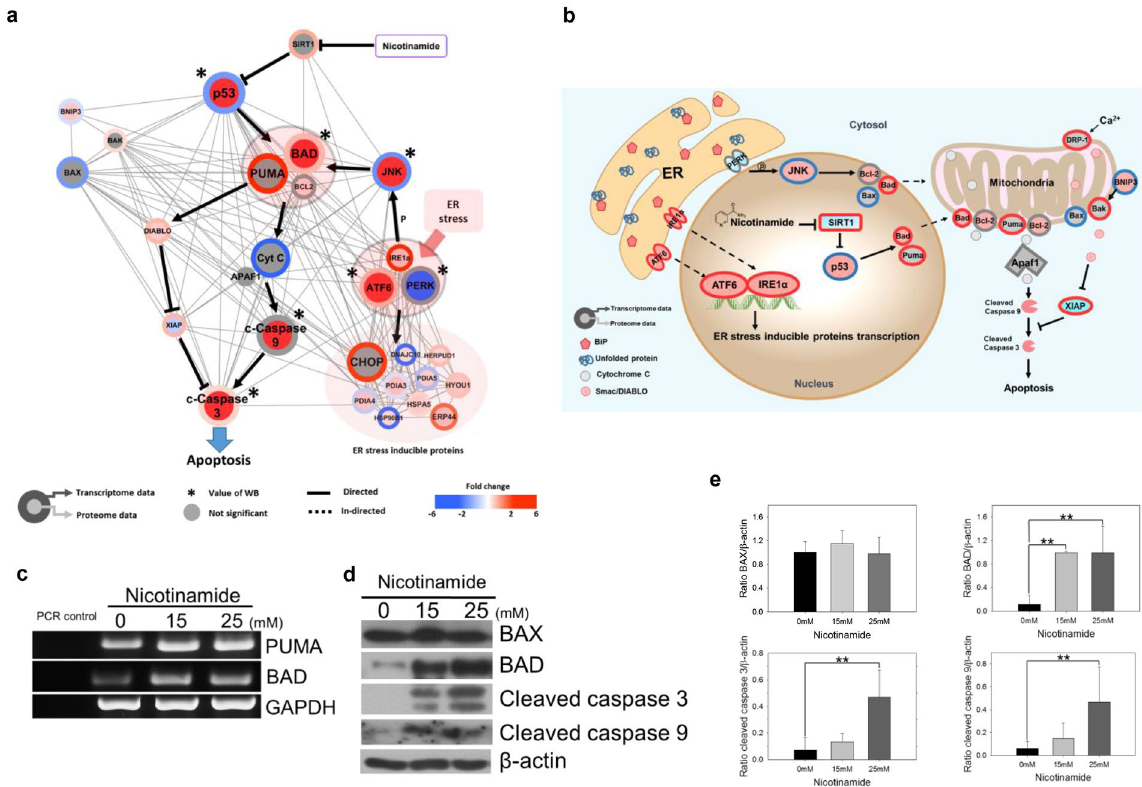
Figure 7. Nicotinamide induces apoptosis in MDA-MB-231 cells. ( a ) Cytoscape visualization of apoptosis regulatory network. The colors of the border and inside circle indicate the expression levels of transcriptome and proteome data, respectively. Gray edge indicates the protein-protein interaction based on the STRING database, whereas the arrows and inhibition symbols represent the activation and repression information, respectively. Nodes with asterisks indicate that the proteins were assessed by only western blotting without the use of proteome data. There is no significant difference regarding the expression level if the color of the node is gray. Pink circle clustering highlights the complex enzymes of proteins. ( b ) Proposed model of nicotinamide- induced apoptosis interaction network. Networks are represented to reflect proteome, transcriptome and western blotting. Red indicates increased expression, blue indicates decreased expression and gray indicates no significant difference. ( c ) The mRNA expression of PUMA (BBC3) and BAD was detected by RT-PCR. PCR control indicated negative control for RT-PCR mix. Expression of GAPDH was measured as a control for RNA integrity. ( d ) The apoptosis-related proteins BAX, BAD, cleaved caspase-9 (c-CASP9) and -3 (c-CASP3) in nicotinamide-treated cells were examined via western blotting. ( e ) Densitometry analysis of BAX, BAD, cleaved caspase-9 (c-CASP9) and -3 (c-CASP3) was quantitated using ImageJ. The values were normalized to the levels of β -actin. The data represent the mean ± SD ( ** P < 0.01) Abbreviations: ER - Endoplasmic Reticulum, p - phosphorylation, WB - western